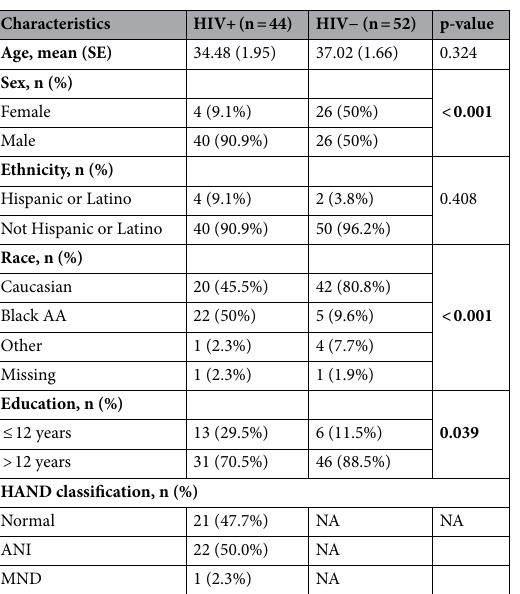
Table 1. Baseline demographics. Continuous variables are summarized as Mean ± Standard Error, categorical variables are summarized as frequency (percentages). Significant p-values are shown as bold. HAND HIV-associated neurocognitive disorders; ANI asymptomatic neurocognitive impairment; MND mild neurocognitive disorder; NA not applicable; AA African